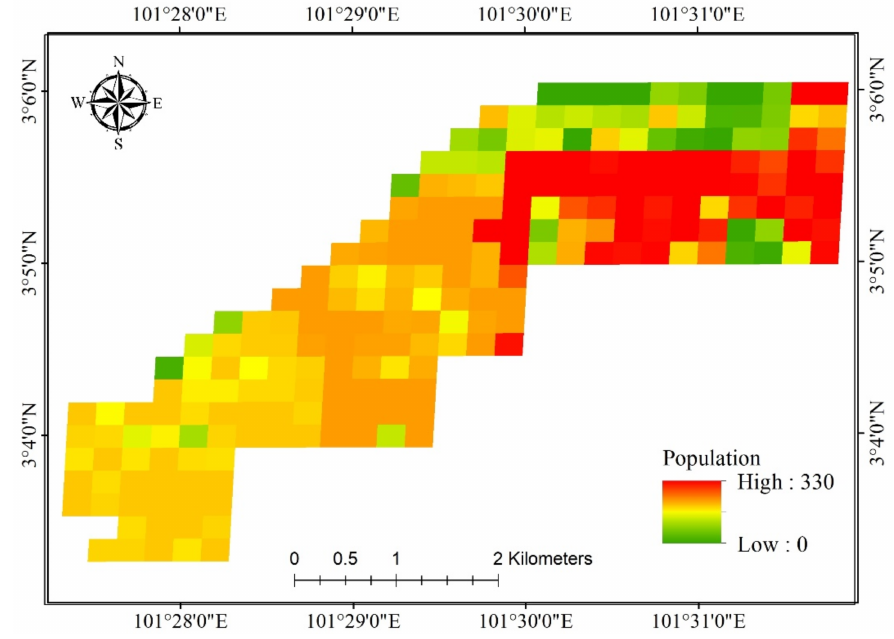
Figure 5. Population